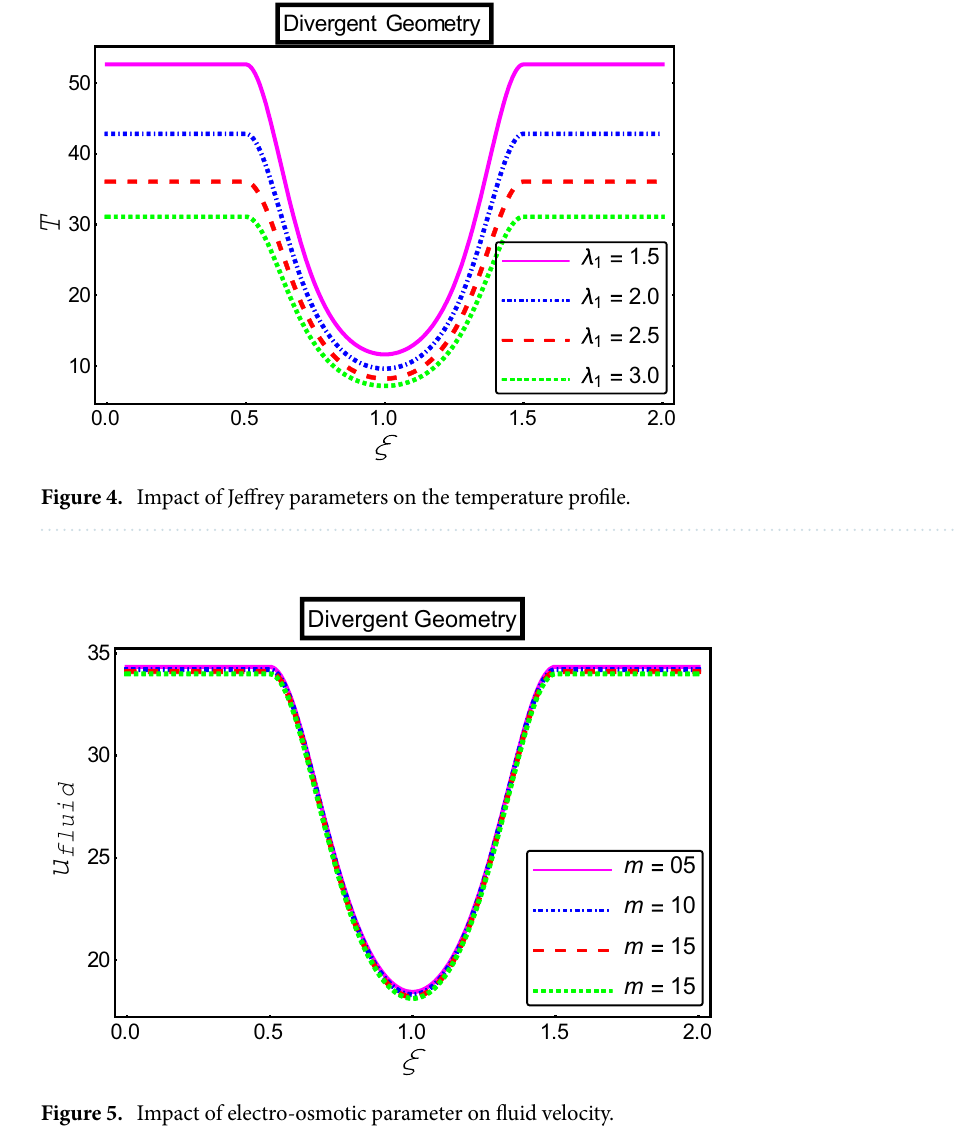
Figure 5. Impact of electro-osmotic parameter on fluid velocity.